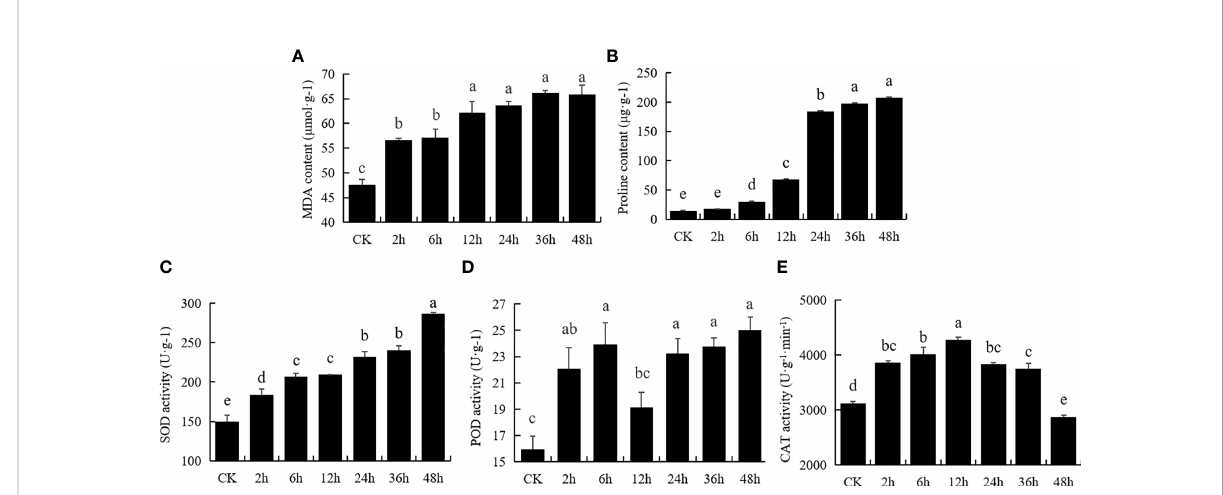
FIGURE 1 Physiological response of Medicago falcata to 400 mM mannitol treatment. Plant samples were collected under normal conditions and treated with 400 mM mannitol for 2 h, 6 h, 12 h, 24 h, 36 h and 48 h. The values are the average and error of three biological replicates. The same letters mean no signi fi cant difference, and different letters mean signi fi cant difference. (A) , MDA content; (B) , Proline content; (C) , SOD activity; (D) , POD activity; (E) , CAT